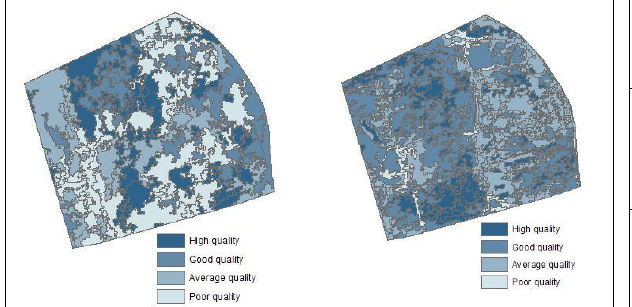
Figure 3. The overlapping area between each segment and the reference classes (TS-X: top left, WV-2: top right) and the number of the reference classes covered by each segment (TS- X: bottom left, WV-2: bottom right). The following criteria were used to create the image segmentation quality map (Figure 4): 1. The class “high quality” comprises segments with an overlapping area of more than 75%, and the number of classes covered by each segment is equal to “1”. 2. The class “good quality” comprises segments with an overlapping area between 50% and 75%, and the number of classes covered by each segment is equal to “2”. 3. The class “average quality” comprises segments with an overlapping area between 25 % and 50%, and the number of classes covered by each segment is equal to “3”. 4. The class “poor quality” comprises segments with an overlapping area of less than 25 %, and the number of classes covered by each segment is equal to “4”.